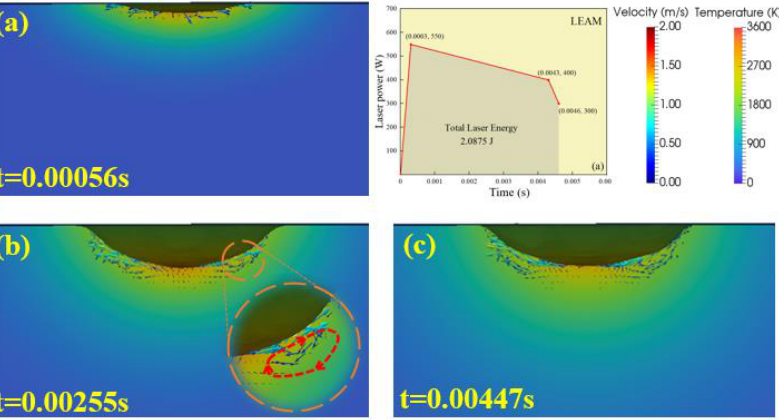
Figure 7. The visual simulation results of the keyhole evolution process in LEAM. ( a ) 0.00056 s, ( b ) 0.00255 s, ( c ) 0.00447 s.